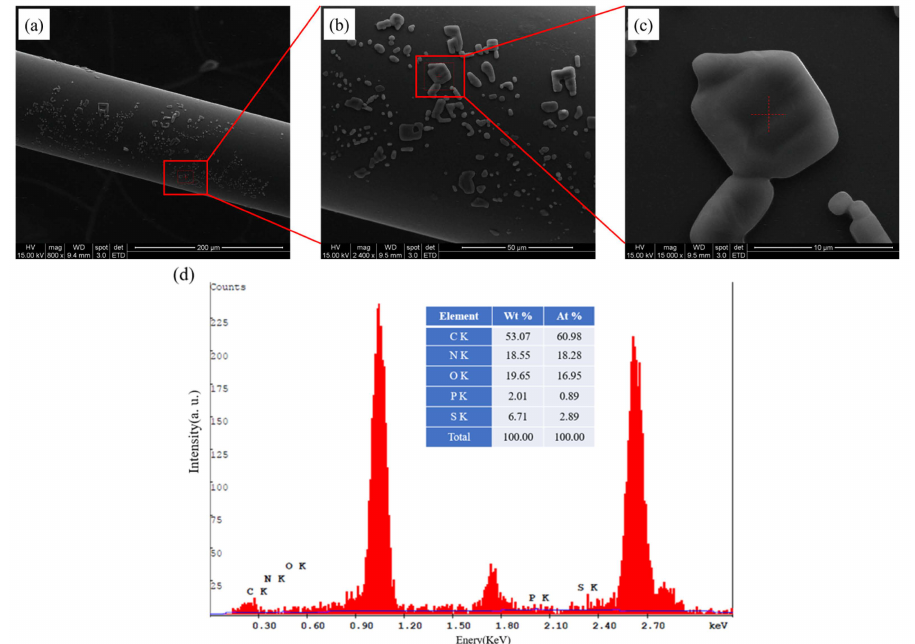
Figure 6. SEM images of the self-assembled layers of the biomedical optical fiber for CCP detection at ( a ) 800 times magnification; ( b ) 2400 times magnification; ( c ) 15,000 times magnification; ( d ) EDS component analysis of the self-assembled layers of the biomedical optical fiber for CCP